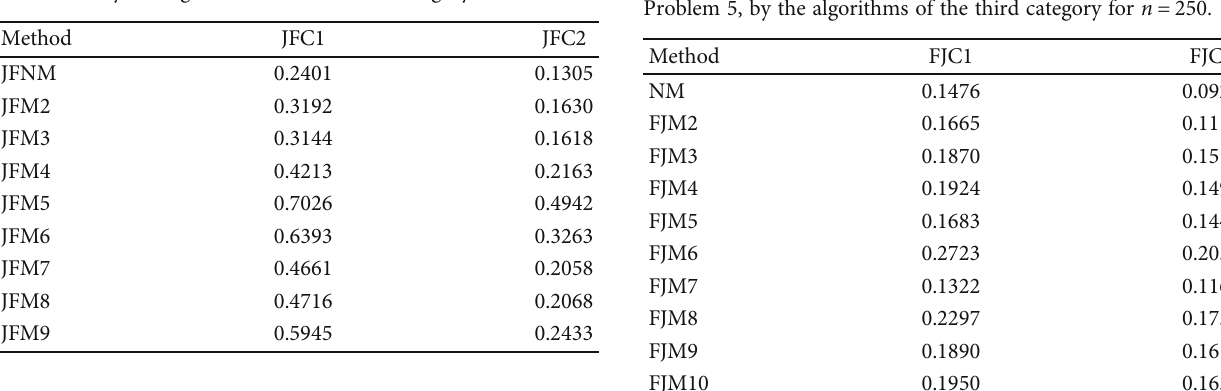
Table 17: Values of JFC1 and JFC2 for methods 1-9 to solve Test Problem 5, by the algorithms of the second category for n = 10 .